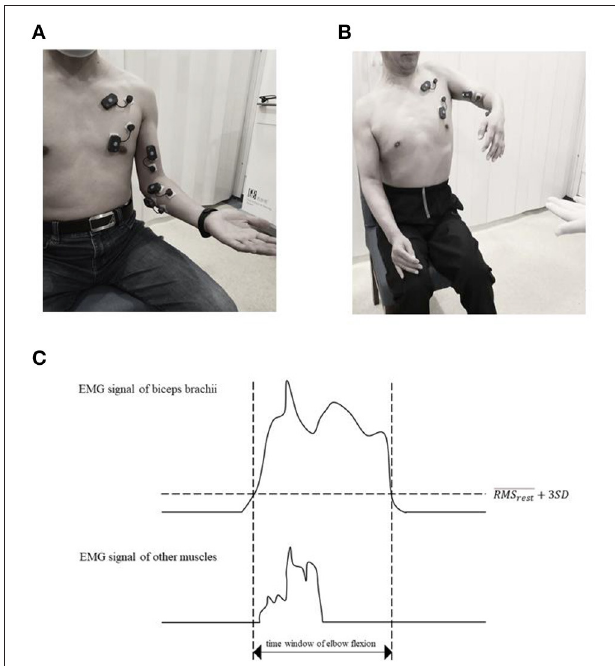
FIGURE 1 | Experiment setup. The participants adopted a sitting position and were asked to flex their elbow while maintaining the neutral position of the shoulder and palm up as much as possible. (A) was the standard motion of the healthy control and (B) was the typical flexor synergy patterns of the patients with stroke. The 5 muscles EMG signals were collected. (C) is a diagram of selecting period of RMS elbow flexion .